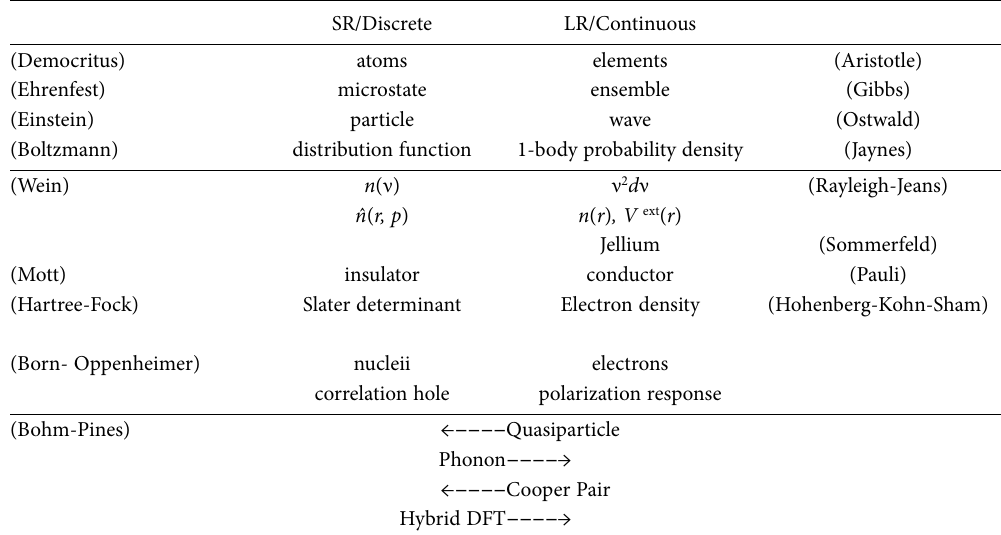
Table 1. Contrasting long-range (LR) and short-range (SR) ideas showing stages of debate over atoms and electrons (top sections), along with concepts from hybrid theories (lower